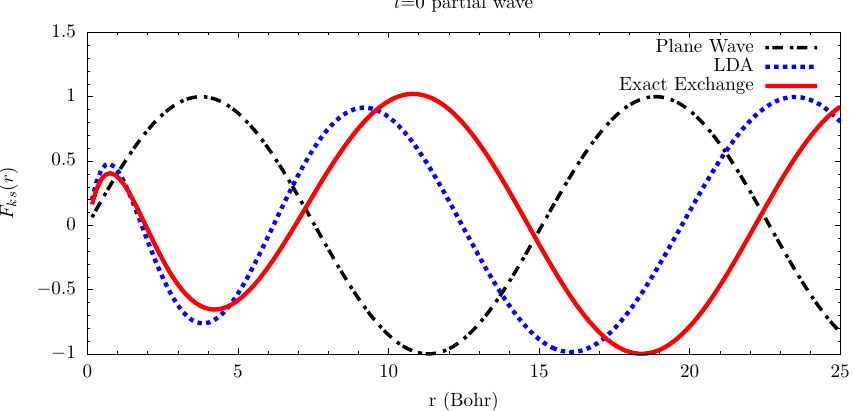
Figure 3. The l = 0 partial wave of the free-electron wavefunction under different approximations. Black dot dashed is the plane wave, dotted blue is using an LDA to approximate the exchange correlations, and solid red is the exact exchange treatment. The states are reacting to the presence of a hydrogen atom in the 2 s state